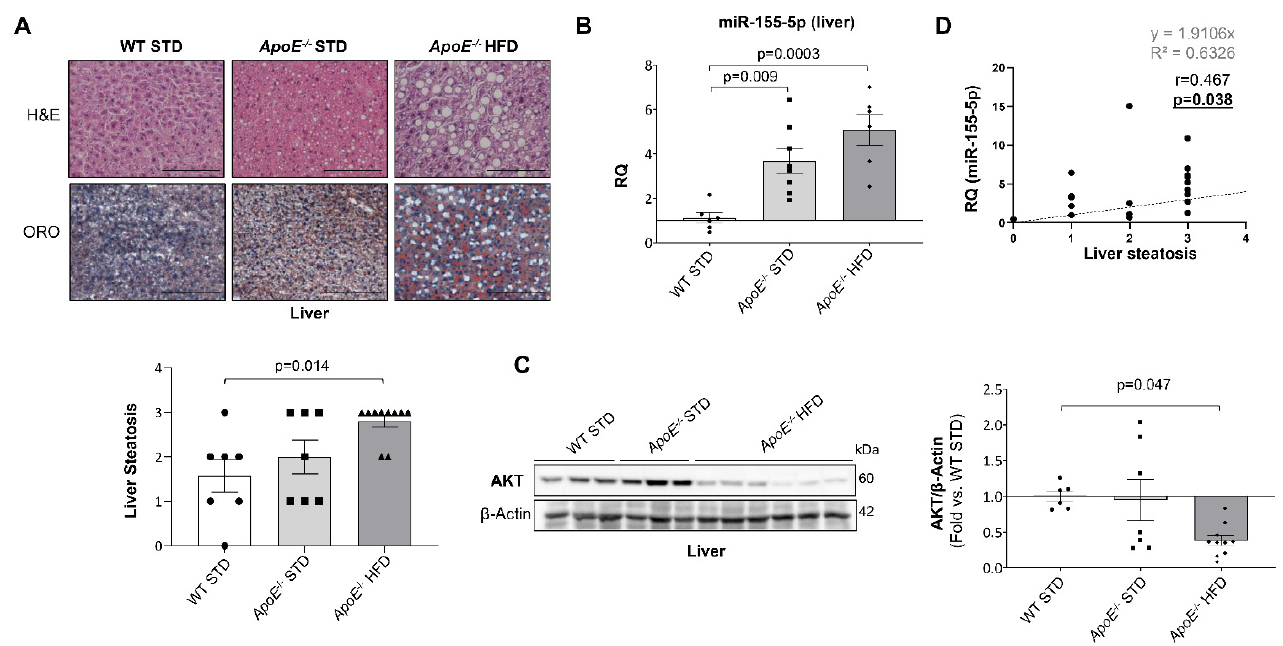
Figure 6. miR-155-5p is overexpressed and AKT downregulated in the liver of the mouse model after 18 weeks of high-fat diet. ( A ) Representative images of H&E staining to perform liver histological analysis ( upper ) and of Oil Red O staining ( lower ) to evaluate hepatic-specific lipid content. Magnification 200 × (scale bar = 25 µ m). Below, its corresponding graph that show the quantification of liver steatosis. ( B ) Relative expression of miR-155-5p in murine liver samples measured by qPCR. ( C ) Representative Western blot images of AKT expression ( left ) and their quantification ( right ) in liver samples from the mouse groups. ( D ) Scatter plots and Spearman’s r correlations between liver steatosis and hepatic miR-155-5p expression. WT= Wild type group; STD = standard type diet; ApoE − / − = ApoE deficient mice; HFD = high-fat diet; AKT = protein kinase B. Image and its quantification steatosis liver: WT STD 18 wks ( n = 7), ApoE − / − STD 18 wks ( n = 7) and ApoE − / − HFD ( n = 10) mice after 18 weeks on the diet. miR-155-5p qPCR liver: WT STD 18 wks ( n = 6); ApoE − / − STD 18 wks ( n = 8); ApoE − / − HFD 18 wks ( n = 6). Western blot of AKT liver: WT STD 18 wks ( n = 6); ApoE − / − STD 18 wks ( n = 7); ApoE − / − HFD 18 wks ( n =